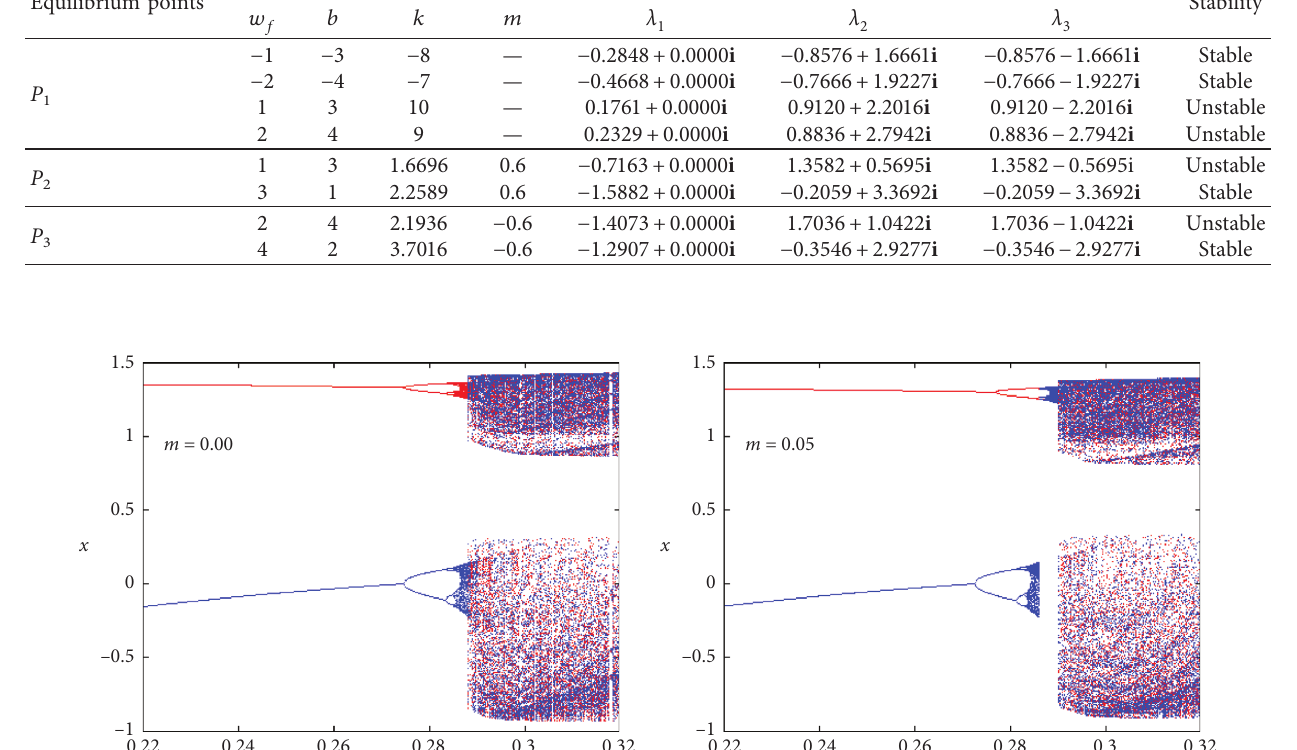
Table 1: Stability of the equilibrium points P Equilibrium points